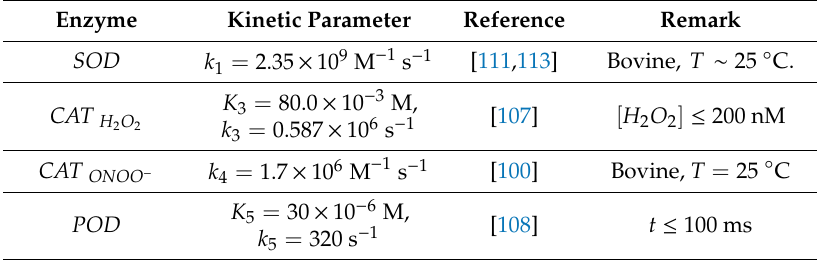
Table 2. Parameter values of the rate constants and Michaelis–Menten constants of the enzyme catalyzed reactions.